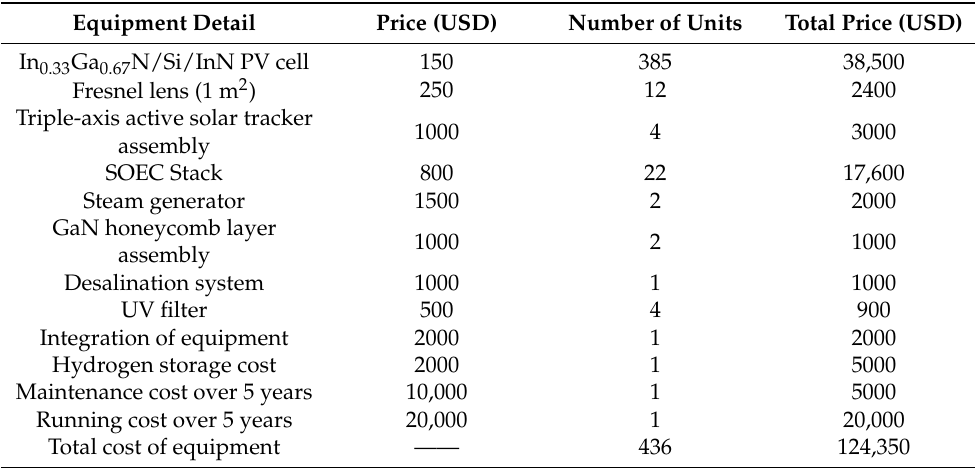
Table 7. The individual costs of components in the proposed